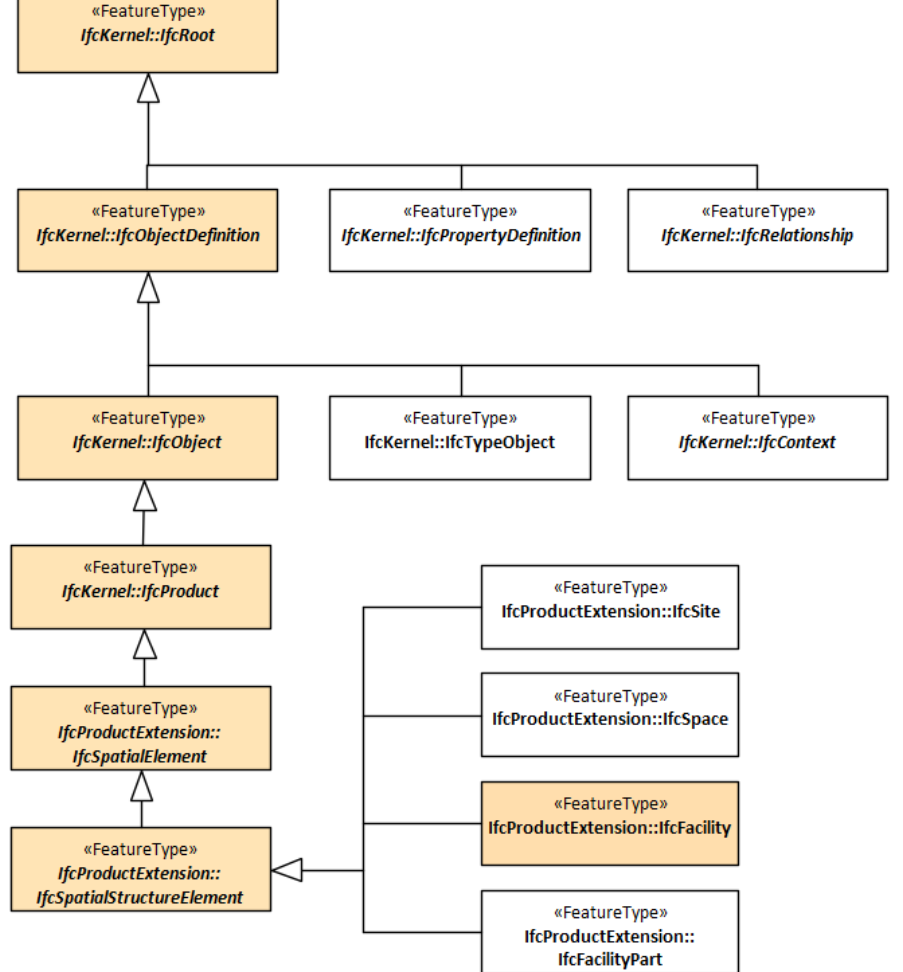
Figure 3. UML class diagram showing a part of the IFC class hierarchy from IfcRoot to IfcFacility.